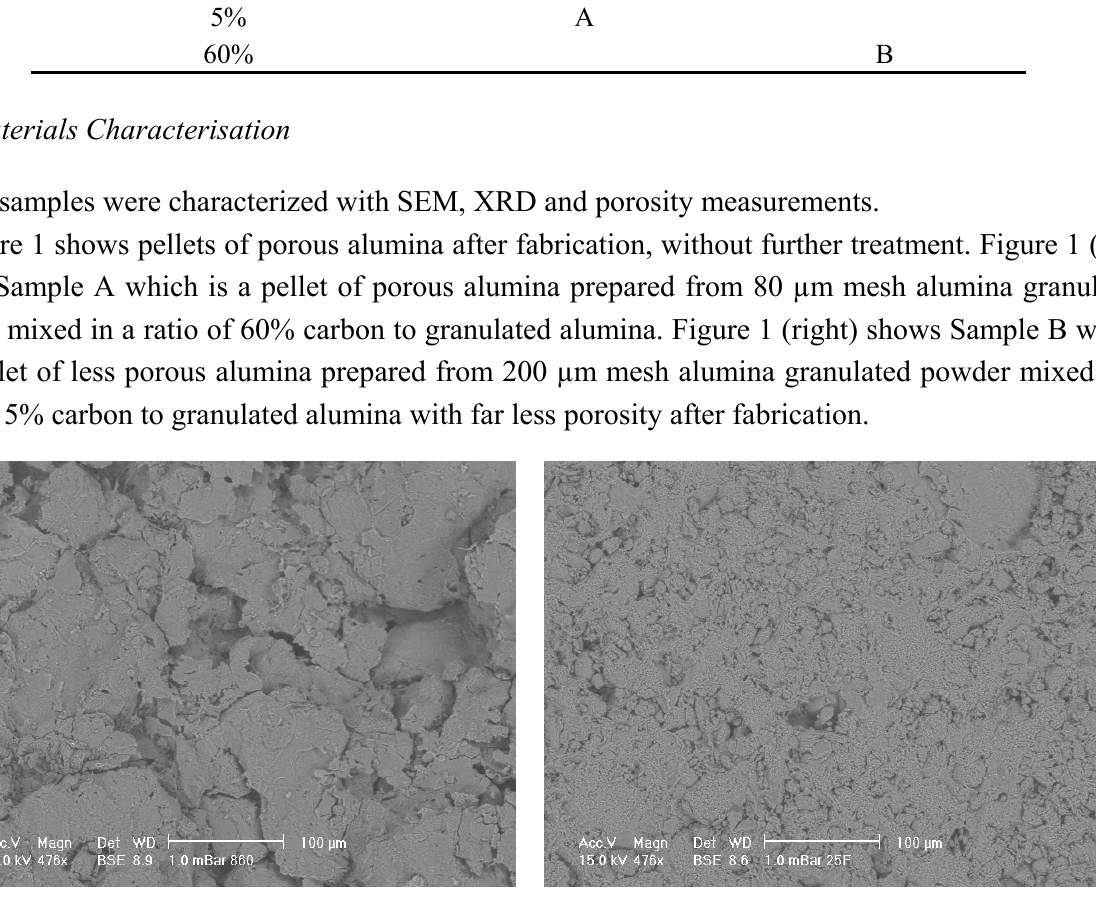
Figure 1. ( left ) SEM micrograph of porous alumina samples before SBF treatment for sample A with original magnification of approximately 500X. Large porous regions are evident; ( right ) SEM micrograph of porous alumina samples before SBF treatment for Sample B with original magnification of approximately 500X. Small porous regions are